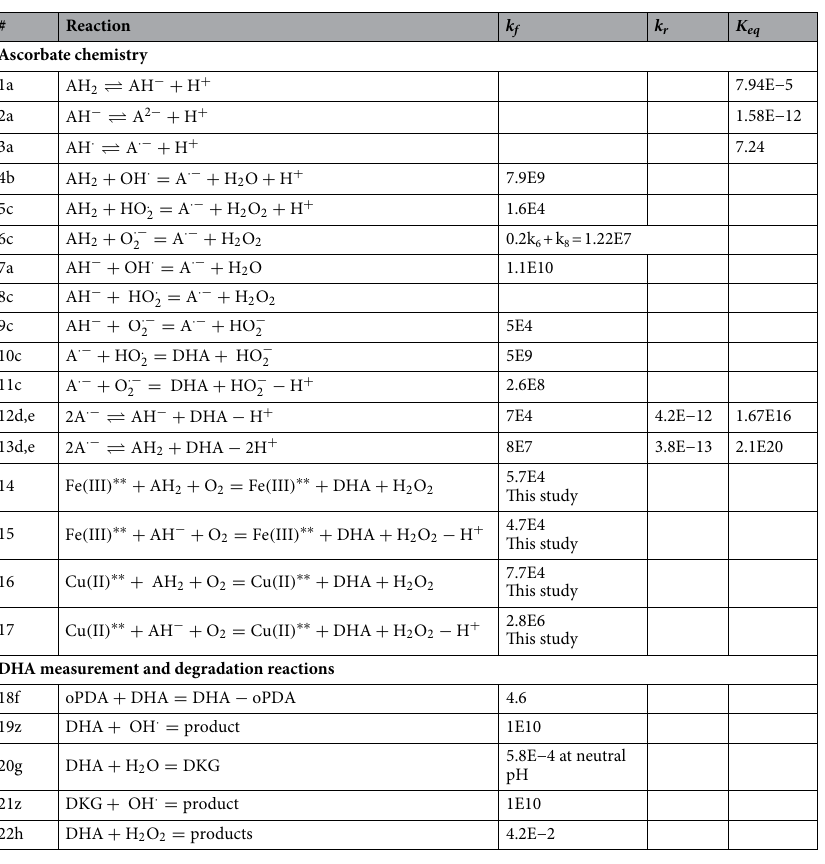
+ 3 + 2 + FeCl 2 + , , FeOH , Fe ( OH ) 2 ,